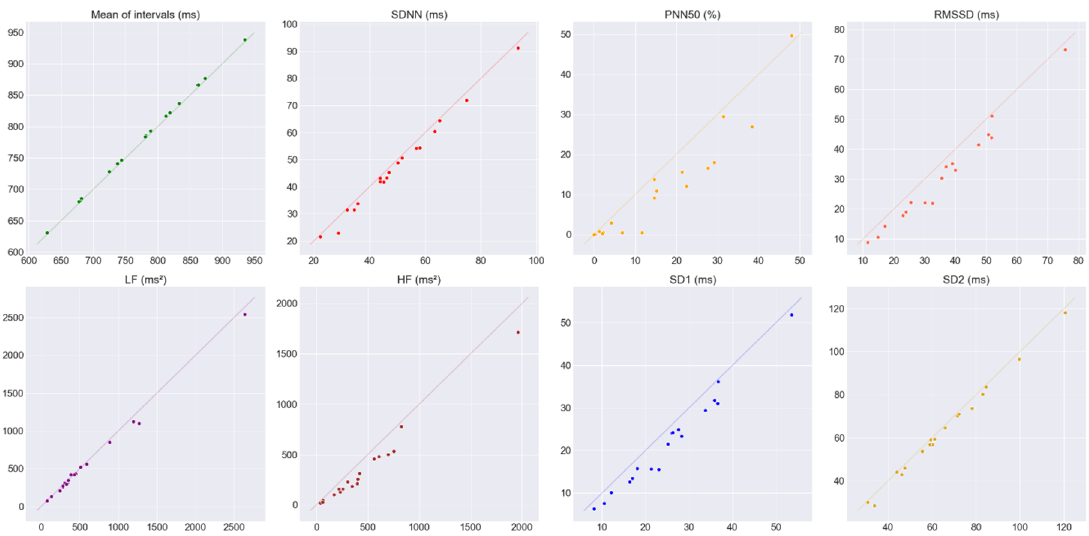
Figure 5. Pairs of HRV metrics obtained at rest plotted against a 45 ◦ line (that would represent a perfect agreement). The HRV metrics obtained from the James One are represented on the x -axis and the ones from the Polar H10 on the y -axis.